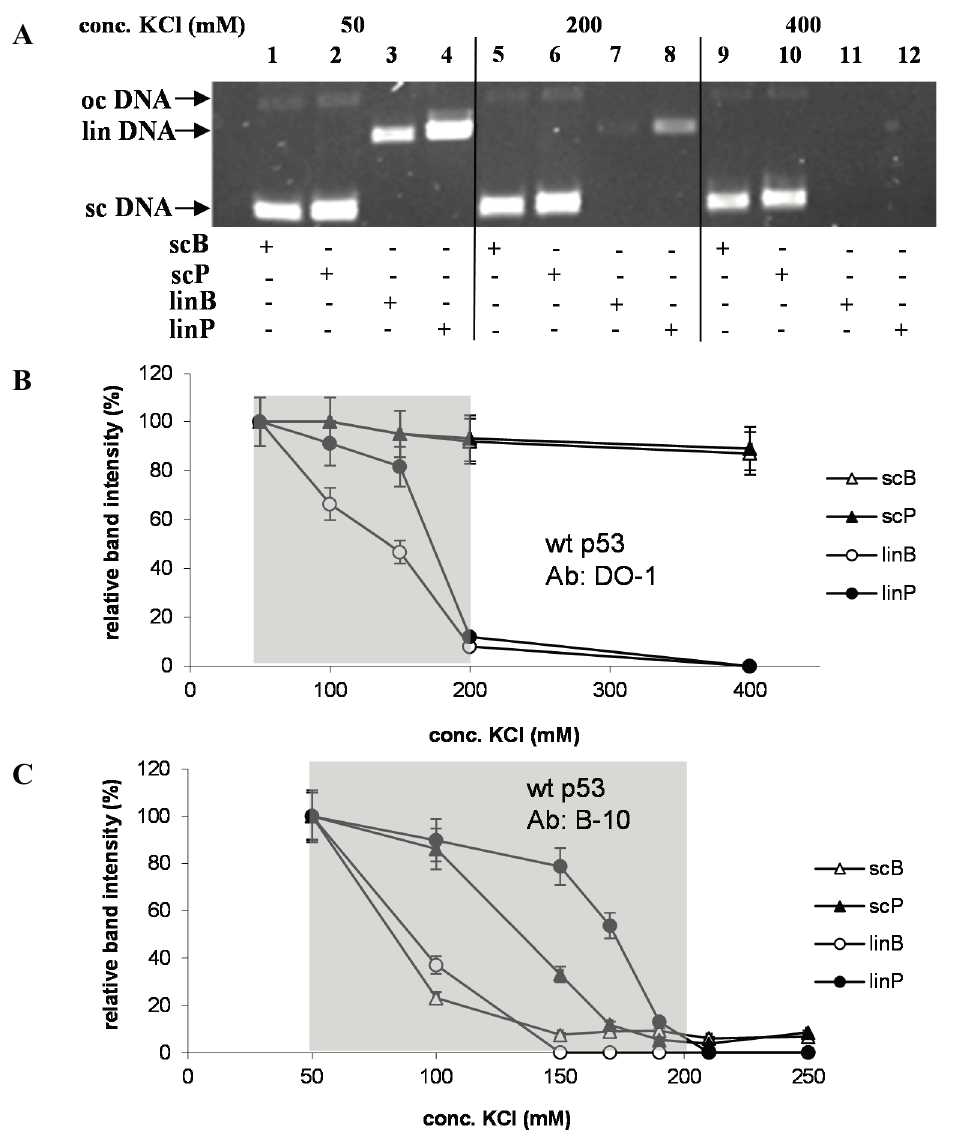
Figure 4. ( A ) Agarose gel electrophoresis of DNA recovered from MBG after incubation of the DO-1-p53-DNA complex at the beads to 50, 200 or 400 mM KCl (see legend on the top) for 30 min at 10 °C (step marked in Figure 1 by arrow 2) followed by the SDS treatment. DNA substrates used are specified on the bottom: scB and scP, supercoiled pBSK and pPGM1 plasmids, respectively, both with native superhelix density ( σ ); linB and linP, the same but linearized plasmids (see Experimental Section); ( B ) Dependence of relative fractions of DNAs resisting salt treatment on KCl concentration to which immunoprecipitated (DO-1)-p53-DNA complex was exposed (conditions as in A). Data obtained from densitometric scanning of ethidium-stained agarose gels; value obtained for 50 mM KCl was taken as 100% for each DNA substrate; and ( C ) As in B but antibody B-10 was used instead of DO-1. Shaded areas in ( B ) and ( C ) indicate region of KCl concentrations between 50 and 200